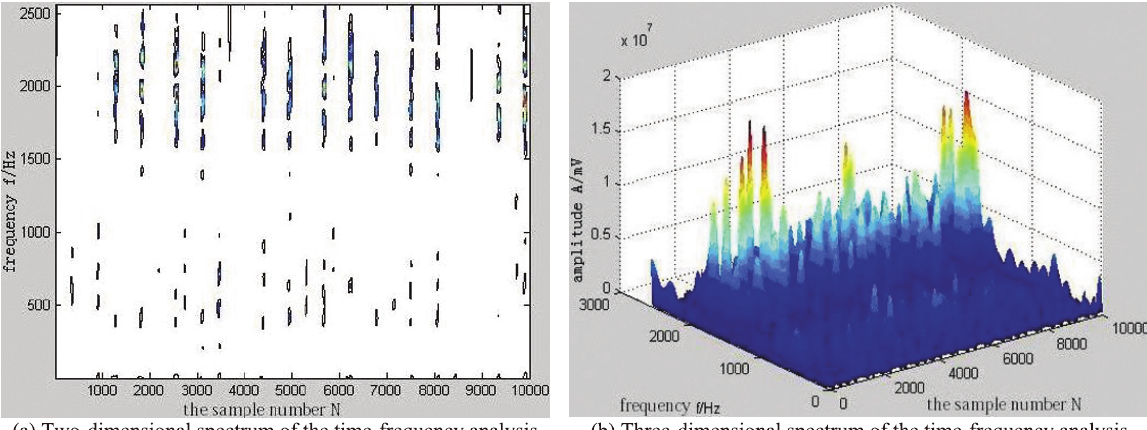
Fig. 8. The time frequency analysis of a tooth wear signal at 300